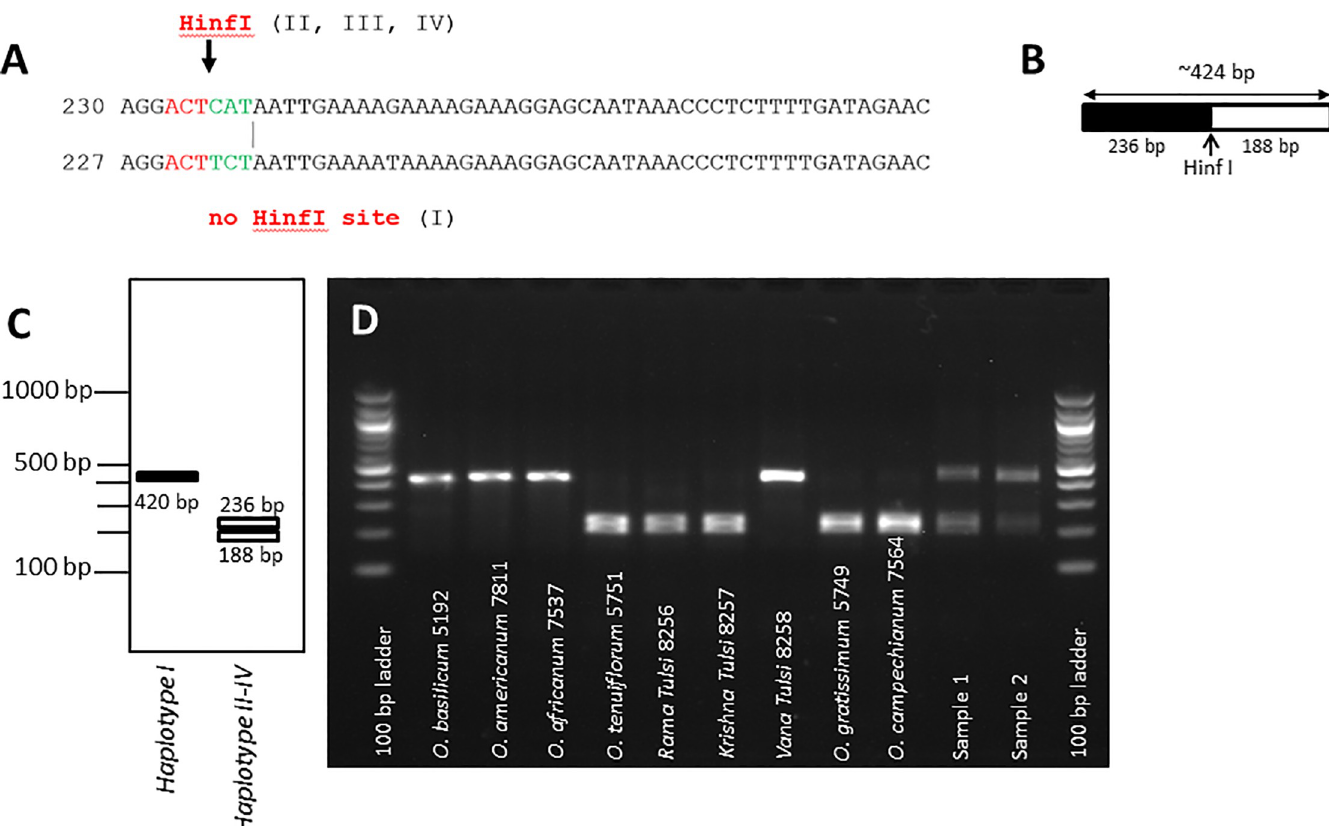
Fig 6. Discrimination of haplotype I and haplotypes II-IV using restriction length polymorphism of the trnH-psbA IGS marker. A Sequence polymorphism between the haplotypes leading to a differential Hinf I recognition site in case of haplotypes II-IV. B Prediction of the fragment size obtained by Hinf I restriction. C Predicted banding pattern for haplotype I and haplotypes II-IV. D restriction patterns obtained after Hinf I digestion of trnH-psbA IGS amplicons in different accessions of Ocimum . Sample 1 and 2 are two commercial samples declaring to contain ‘Rama’, ‘Krishna’, and ‘Vana’